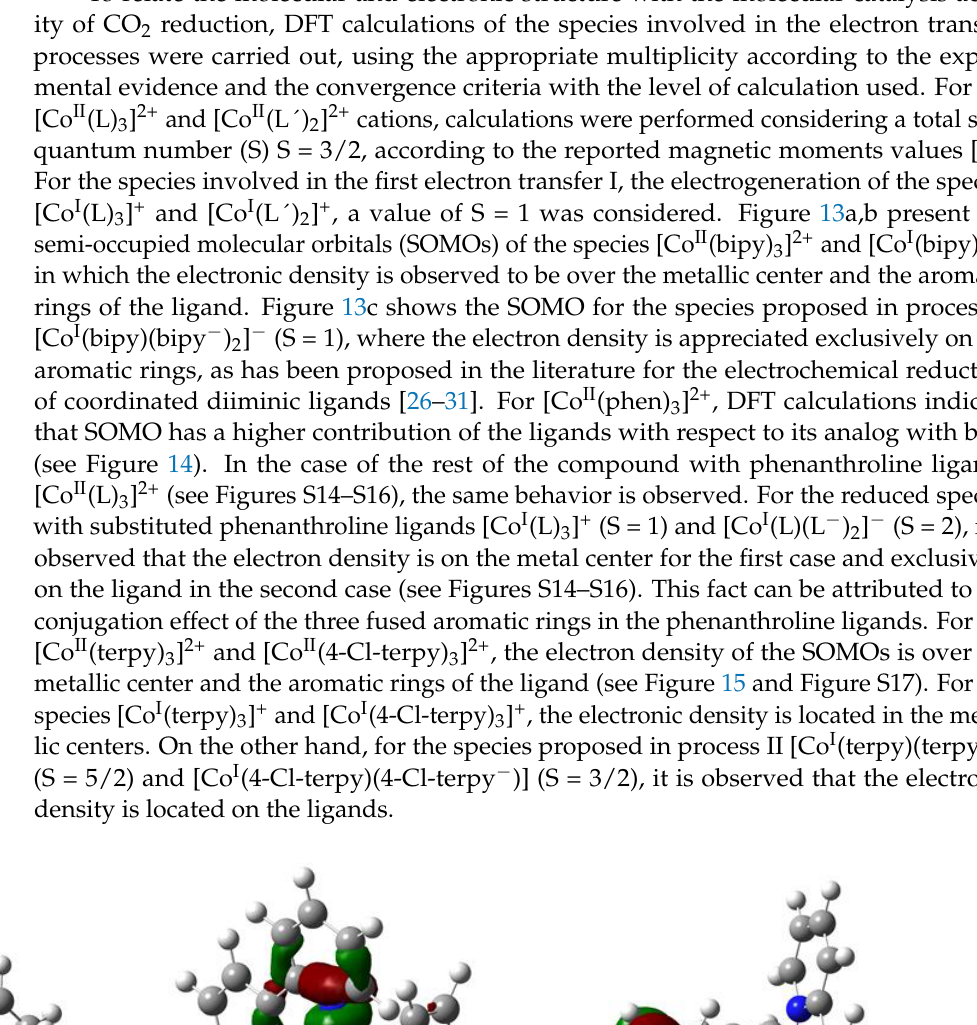
(c) Figure 14. SOMO diagrams of the species ( a ) [Co II (phen) 3 ] 2+ , ( b ) [Co I (phen) 3 ] + , and ( c ) [Co I (phen)(phen − ) 2 ] − . ( a ) ( b ) ( c ) Figure 15. SOMO diagrams of the species ( a ) [Co II (terpy) 3 ] 2+ , ( b ) [Co I (terpy) 2 ] + , and ( c ) [Co I (terpy)(terpy − )].